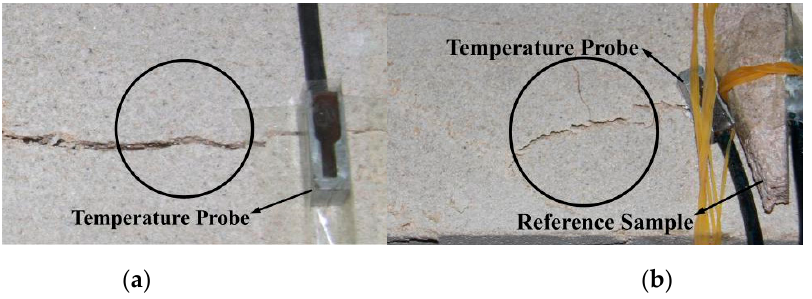
Figure 2. ( a ) Photographs of sample sy20–3 with fracturing mode of extensional fissures; ( b ) photographs of sample sy20–1 with fracturing mode of local bulging.